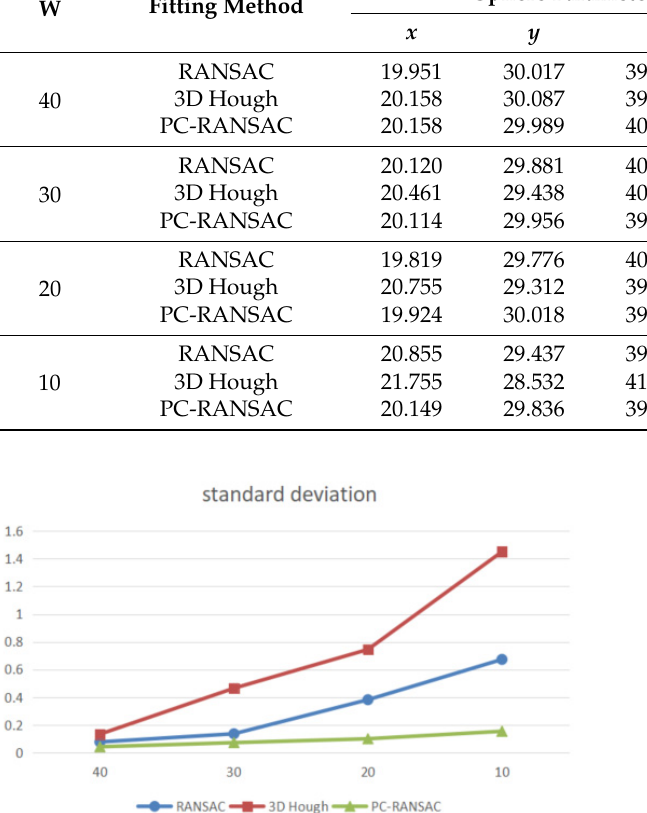
Table 1. Sphere detection results of simulation data for each method. W